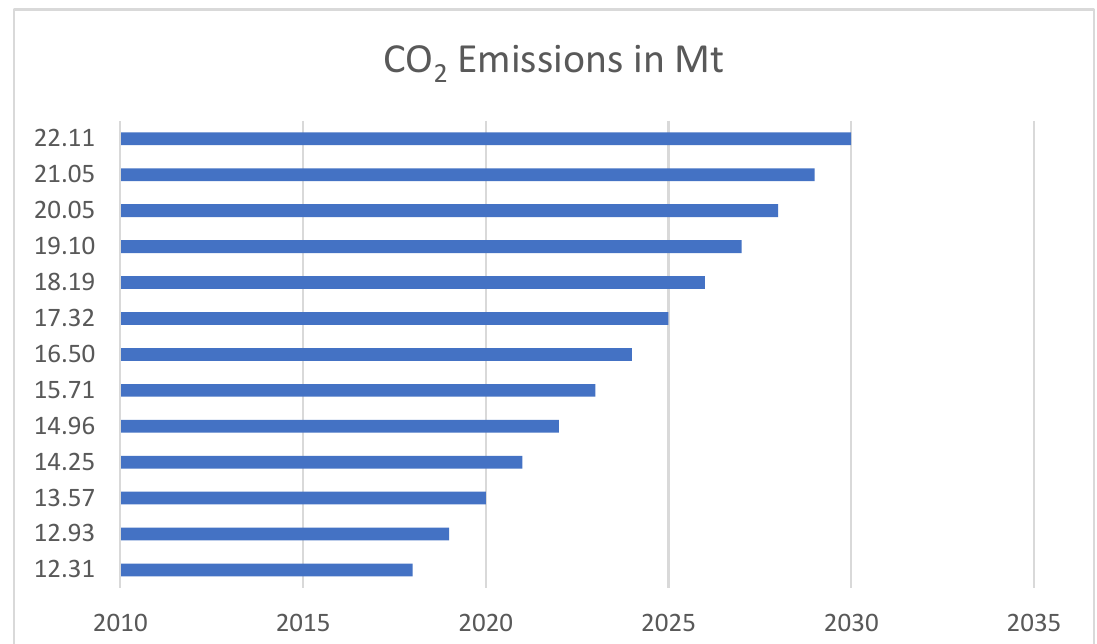
Figure 11. CO 2 eq emissions forecast: iron and steel industries.